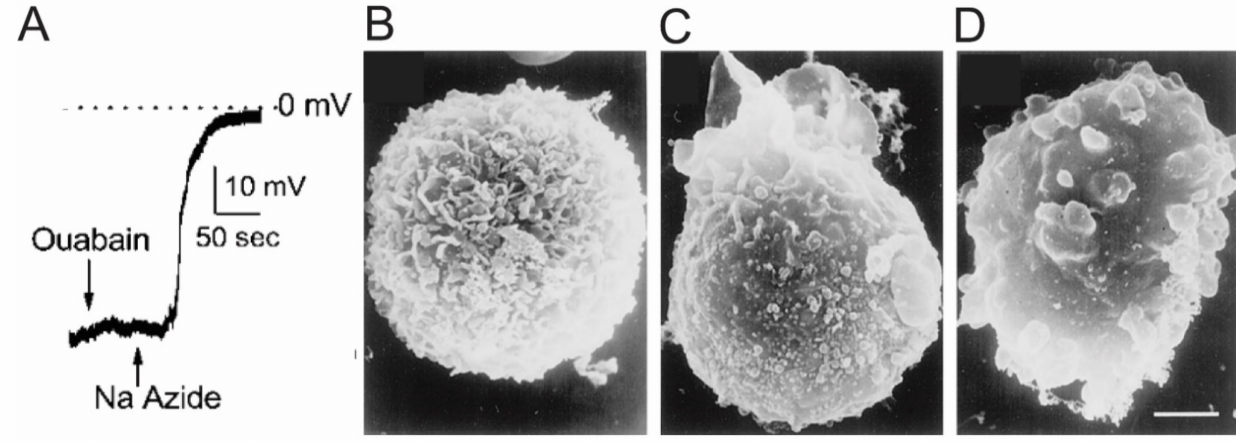
Figure 2. ( A ) Sodium azide induced ATP depletion, resulting in cellular depolarization. Current clamp recording demon- strating cellular resting potential (~60 mV). After exposure to 1 mM oubain (downward arrow), cell depolarization was <5 mV with rapid recovery after washout. Conversely, 3 min exposure to 1 mM sodium azide induced ATP depletion and resulted in a depolarizing inward current with cell depolarization to almost 0 mV. Scanning electron micrograph of a freshly isolated reactive astrocyte under control conditions ( B ), 5 min after exposure to 1 mM sodium azide ( C ) and 25 min after exposure to 1 mM sodium azide ( D ). Scale bar is 12 µ m. Adapted with permission from Ref.